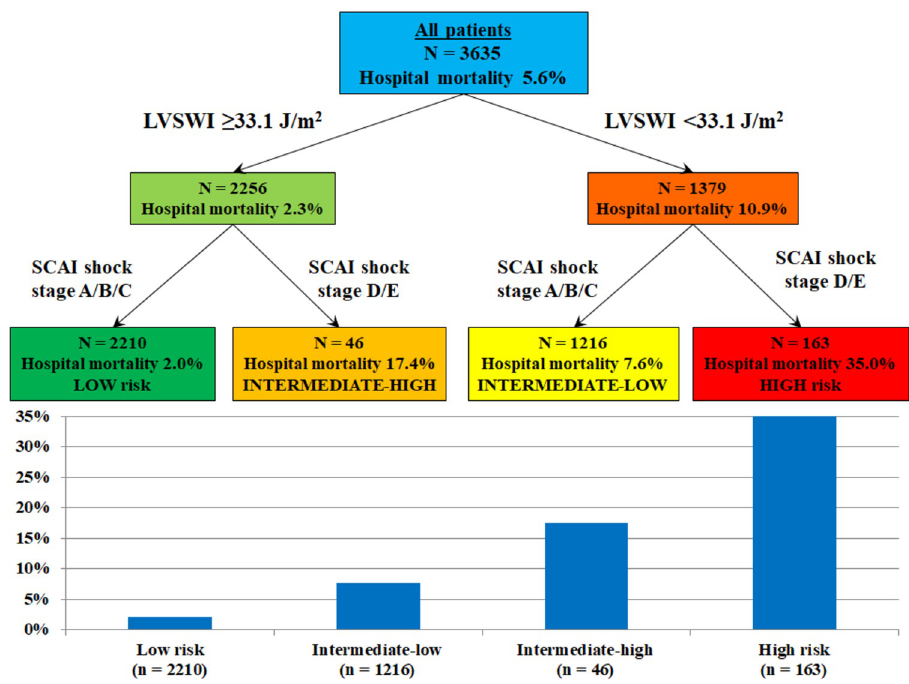
Fig 6. Classification and regression tree (CART) analysis using ECHO-LVSWI and SCAI shock stage for stratification of in-hospital mortality risk.